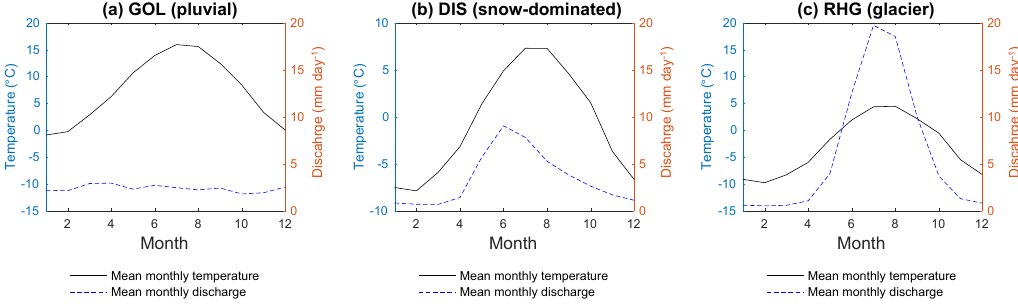
Figure 2. Annual cycle of discharge and air temperature for three selected catchments representing three different hydrologic regimes (pluvial, snow-dominated and glacier). The mean monthly values computed over the entire observation period for each catchment are shown (see Table 1).